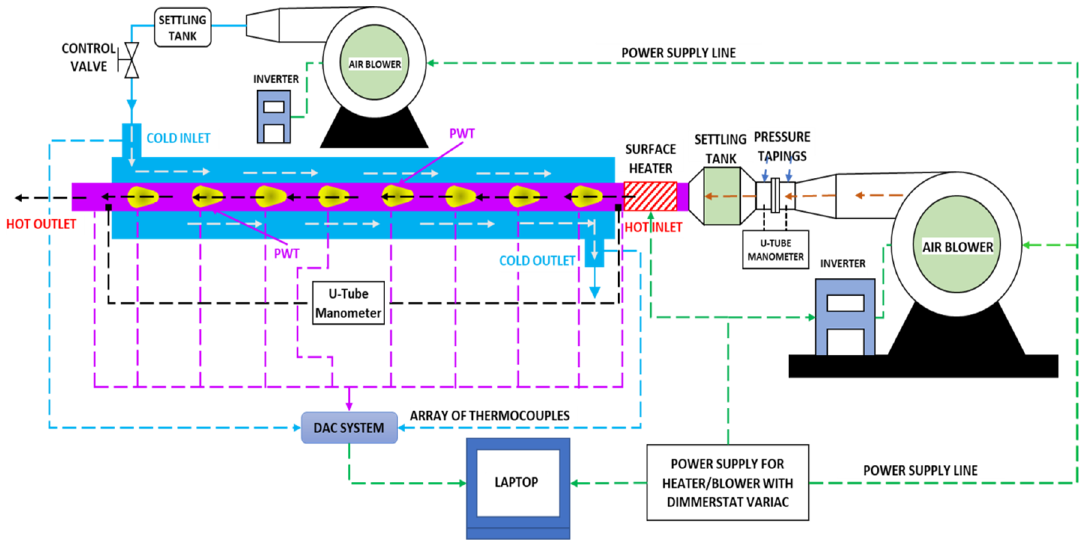
Figure 1. DHX Investigation Setup